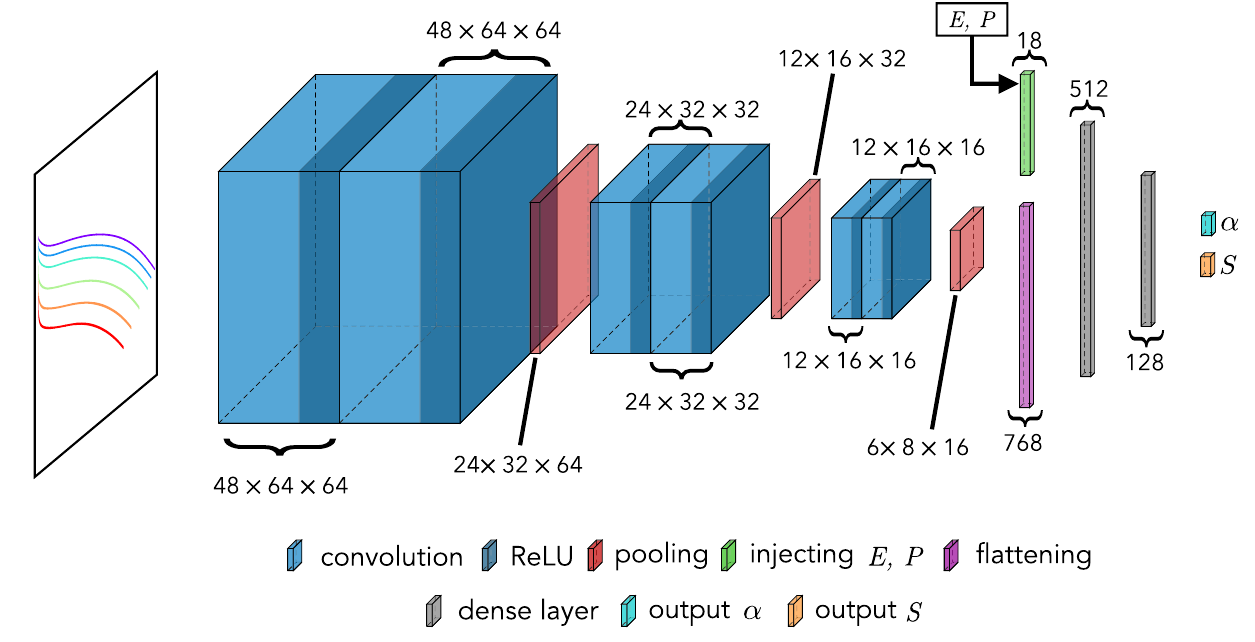
Figure 1. Convolutional neural network architecture to infer microstructural battery parameters. The CNN is comprised of convolution blocks and fully connected layers, which takes two types of input at different stages. The model takes the color-encoded voltage versus capacity curves as the main input (each color corresponding to a current density), energy density, E , and power density, P , as the second input. Each convolution block has two convolutional layers, followed by a pooling layer. A ReLU activation function is placed after each convolutional layer and hidden dense layer. For each data point, the image with voltage curves are fed into the network. For each curve, E and P are taken into the following fully connected layers, along with the higher-level representation of the input image. The output of this network has two components, the Bruggeman exponent, α , and the area density shape factor, S . See text for details.